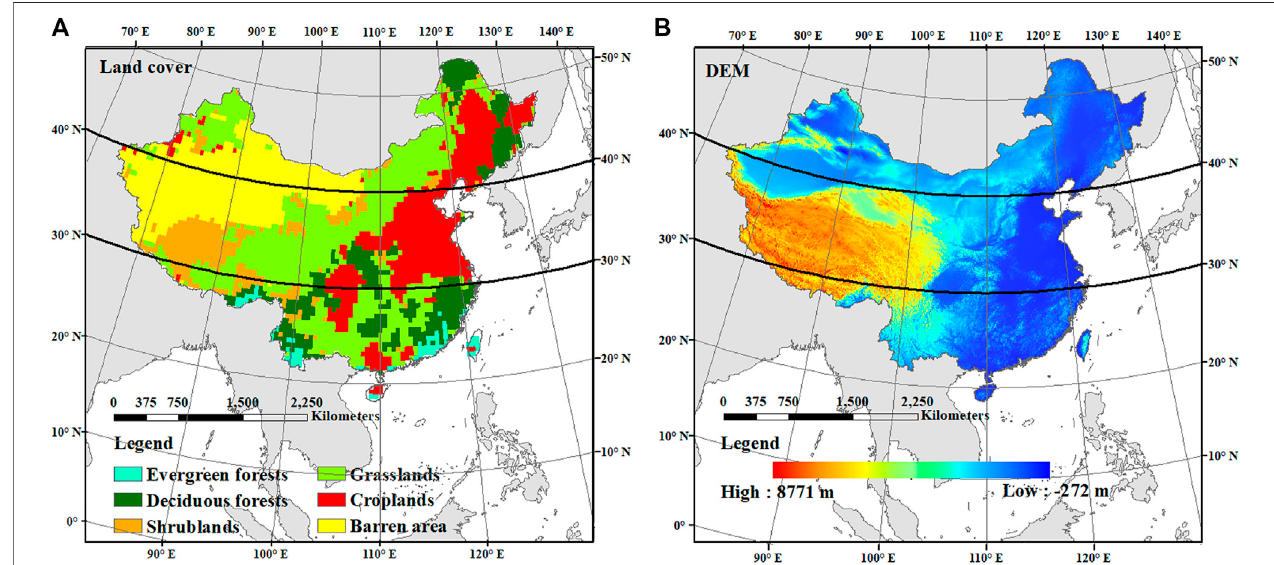
FIGURE 1 | Land cover map (A) and DEM (B) of China. The land cover was reclassi fi ed into evergreen forests, deciduous forests, shrublands, grasslands, croplands,andbarrenareas.Thespatialresolutionofthelandcovermapisprocessedto0.5 ° ×0.5 ° .Thestudyareawasdividedintothehigh-,middle-,andlow-latitude regions by the bold and solid lines in the two